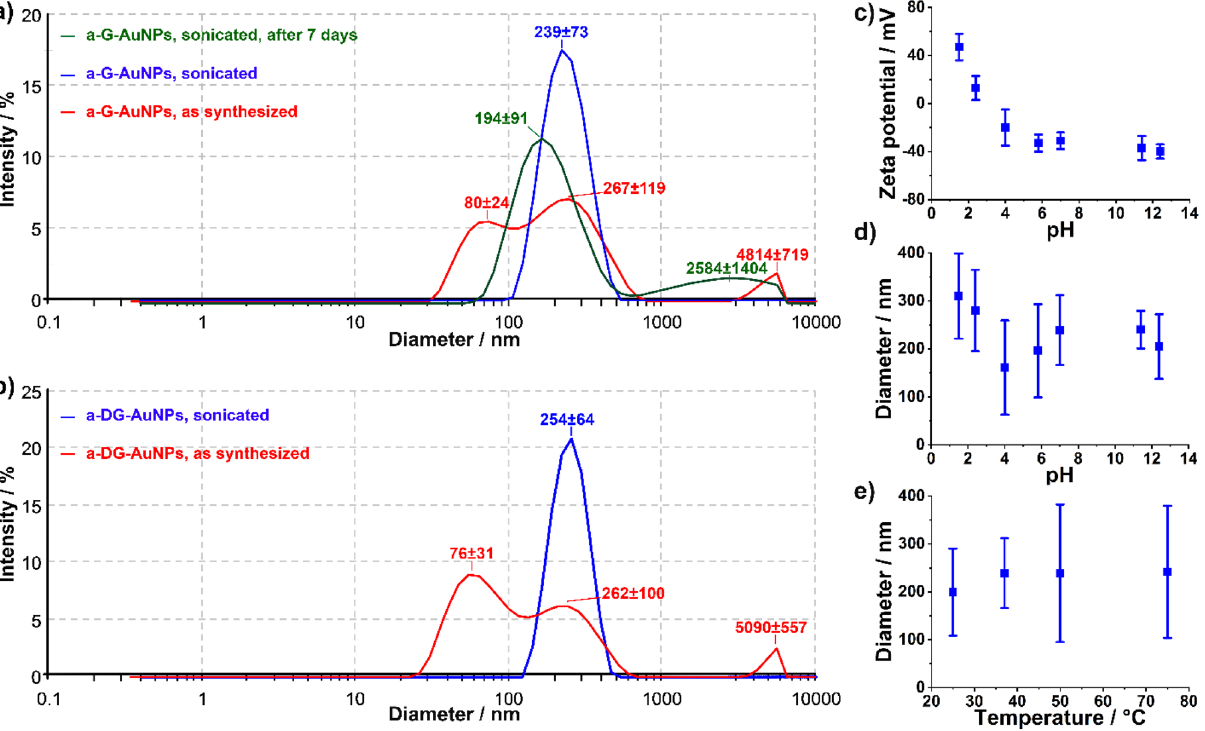
Figure 2. DLS measurements. Size distribution profiles of G-AuNPs ( a ) and DG-AuNPs ( b) . Zeta potential ( c ) and diameter ( d ) of G-AuNPs as a function of pH. Diameter ( e ) of G-AuNPs as a function of